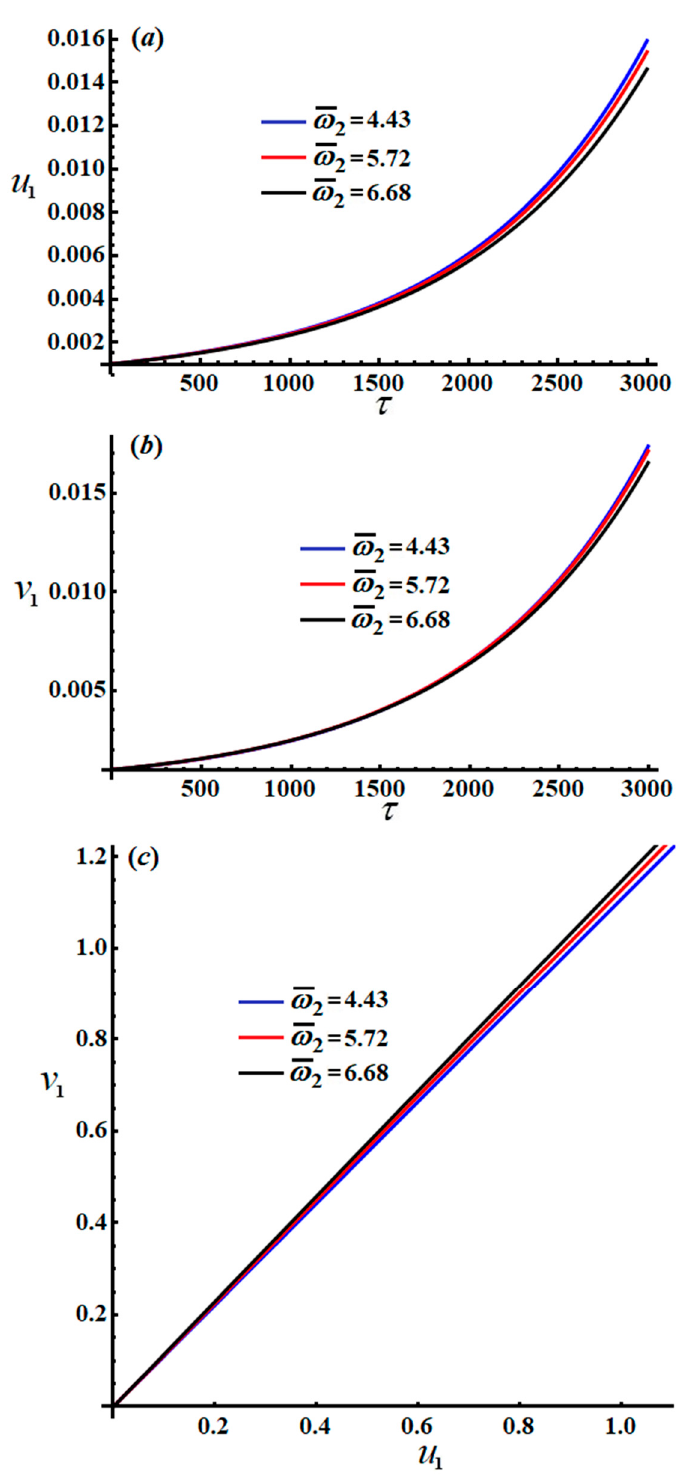
τ Figure 18. The modified amplitudes via and the projections of the modulation equation tracks Figure 18. The modified amplitudes via τ and the projections of the modulation equation tracks on the phase plane u 1 v 1 : ( a – c ) when ω 2 = ( 4.43,5.72,6.68 ) on the phase plane